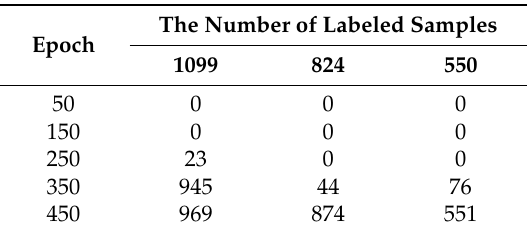
Table 4. The number of high-quality samples in 1000 generated samples from the 50th, 150th, 250th, 350th, and 450th epoch with different numbers of labeled samples.